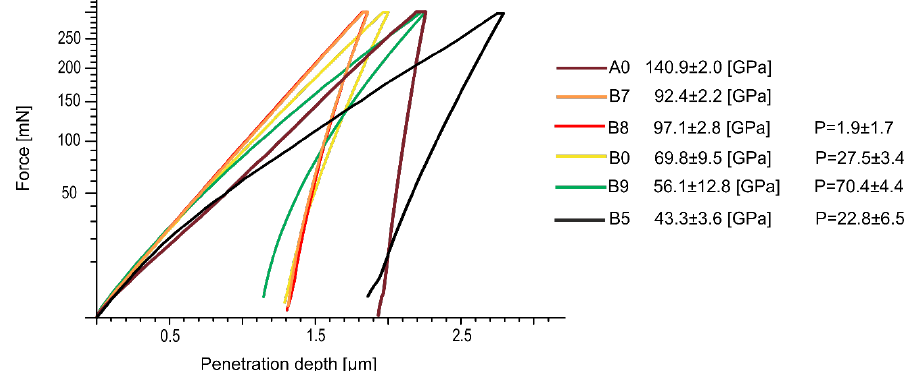
Figure 5. Nanoindentation load–depth curves of Ti23Zr25 alloys produced with hot pressing (B8), cold pressing with sintering (B0), as foams with ammonium bicarbonate (B9), and modified with 9% of 45S5 Bioglass addition (B5). Curves were contrasted with commercially pure Ti (A0) and microcrystalline arc-melted Ti18Zr24Nb (B7). The porosity results based on planimetric analysis (P) of each material were also provided.